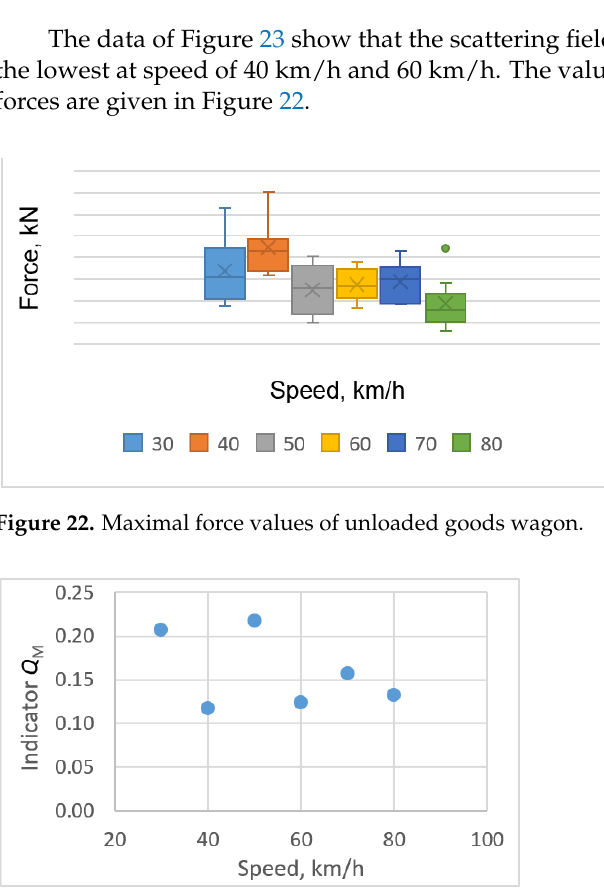
Figure 23. Values of Q M considering to the maximal vertical forces of unloaded goods wagon.